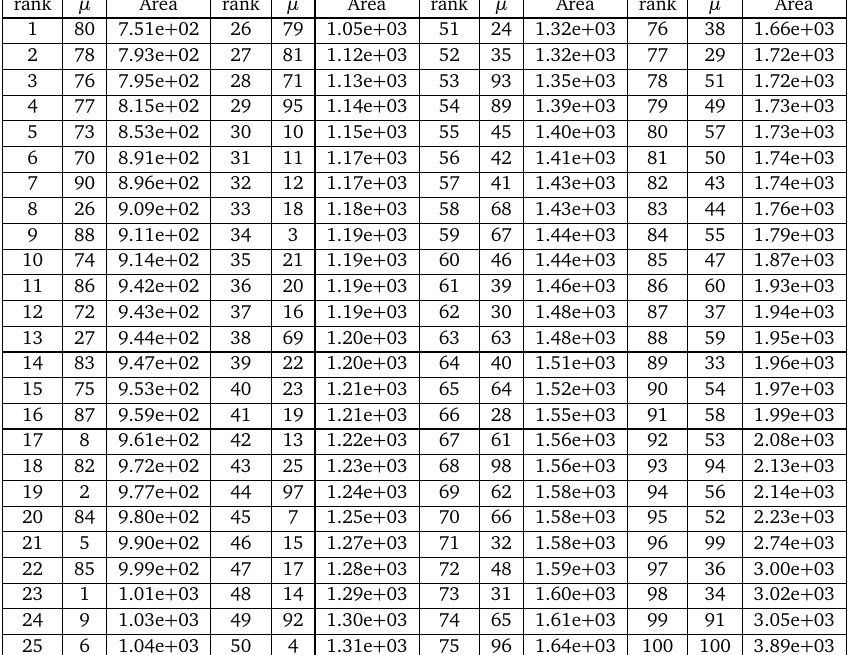
Table 17: Area between ideal cumulative density curve and the cumulative density curves of the robust optimization runs for various hyperparameters µ for the A14 full dataset (smaller values are better). The data are organized in ascending order of the area between the curves.